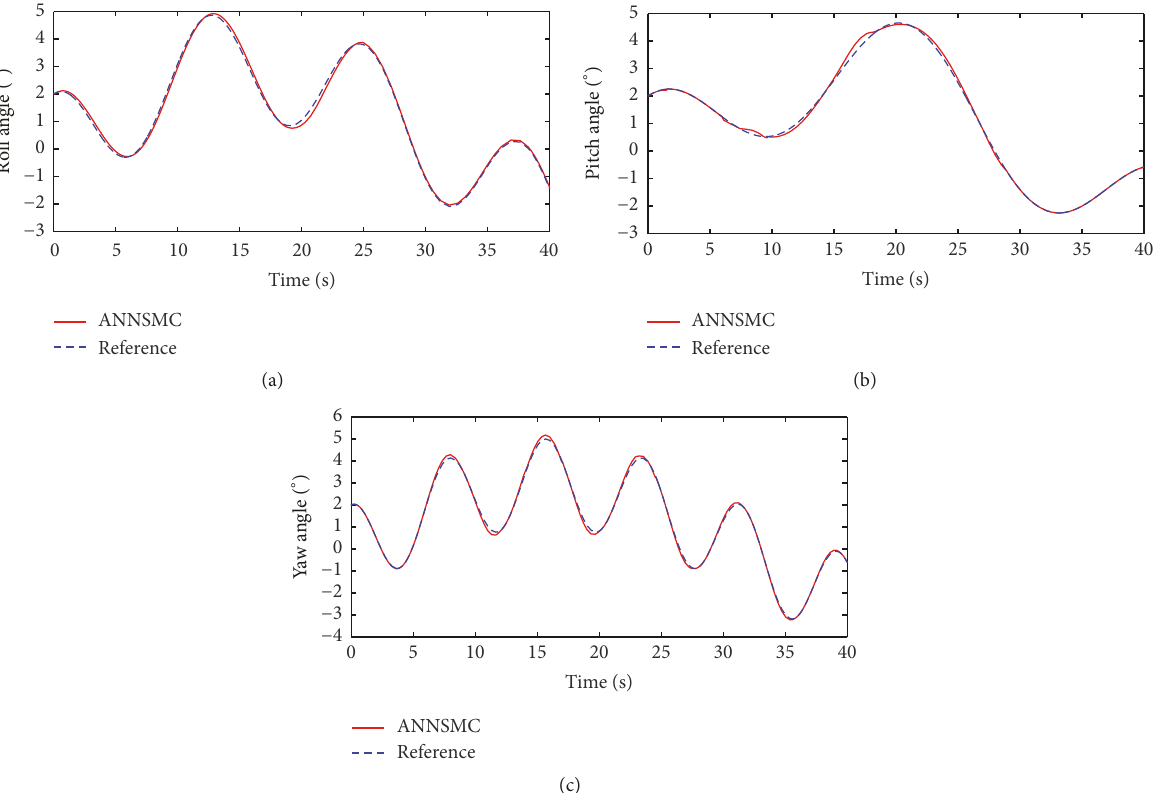
Figure 10: Helicopter attitude behavior response to the hybrid superposition